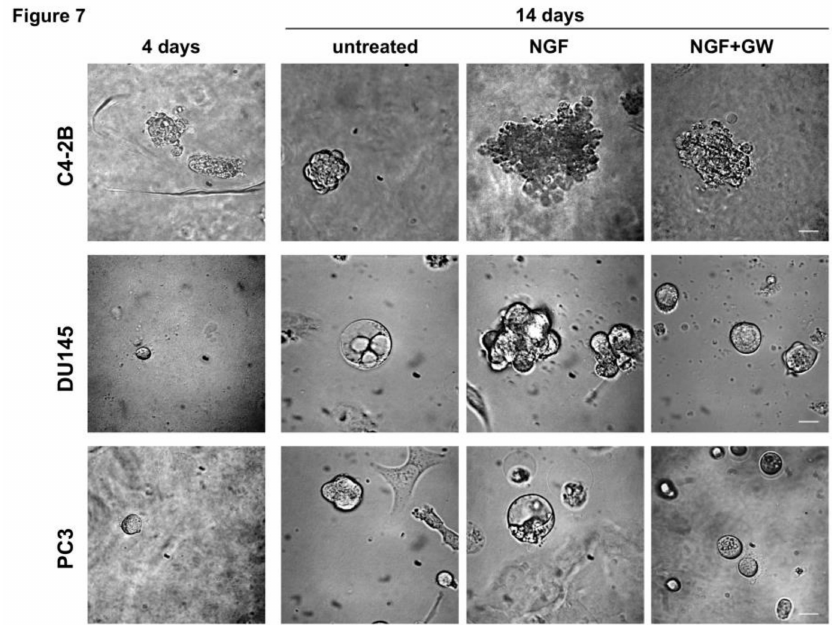
Figure7. Nervegrowthfactor(NGF)increasesthegrowthoforganoidsfromcastrationresistant-prostate cancer (CRPC) cells through Tropomyosin receptor kinase (TrkA) activation. C4-2B (upper panel), DU145 (middle panel) and PC3 (lower panel) were used in miniaturized 3D cultures in extracellular matrix (ECM), as reported in Methods. Four days after cells embedding in VitroGel-3D-RGD, representative images were acquired as described in Methods. 3D cultures were left untreated or treated with 100 ng / mL NGF, in the absence or presence of GW441756 (GW; 1 µ M) for 14 days. Shown are phase-contrast images captured at 14th day. Scale bar, 100 µ